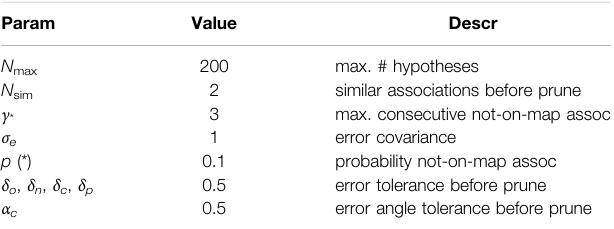
TABLE 1 | The con fi guration parameters used in our method for evaluating the hypothesis tree. Param